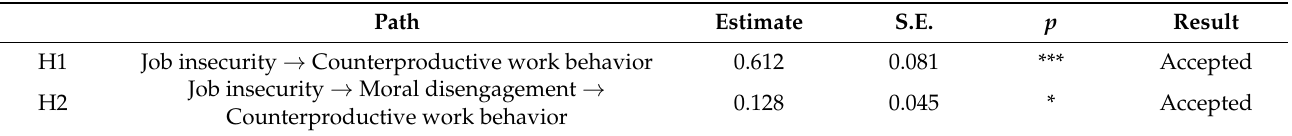
Table 2. Testing results of the structural